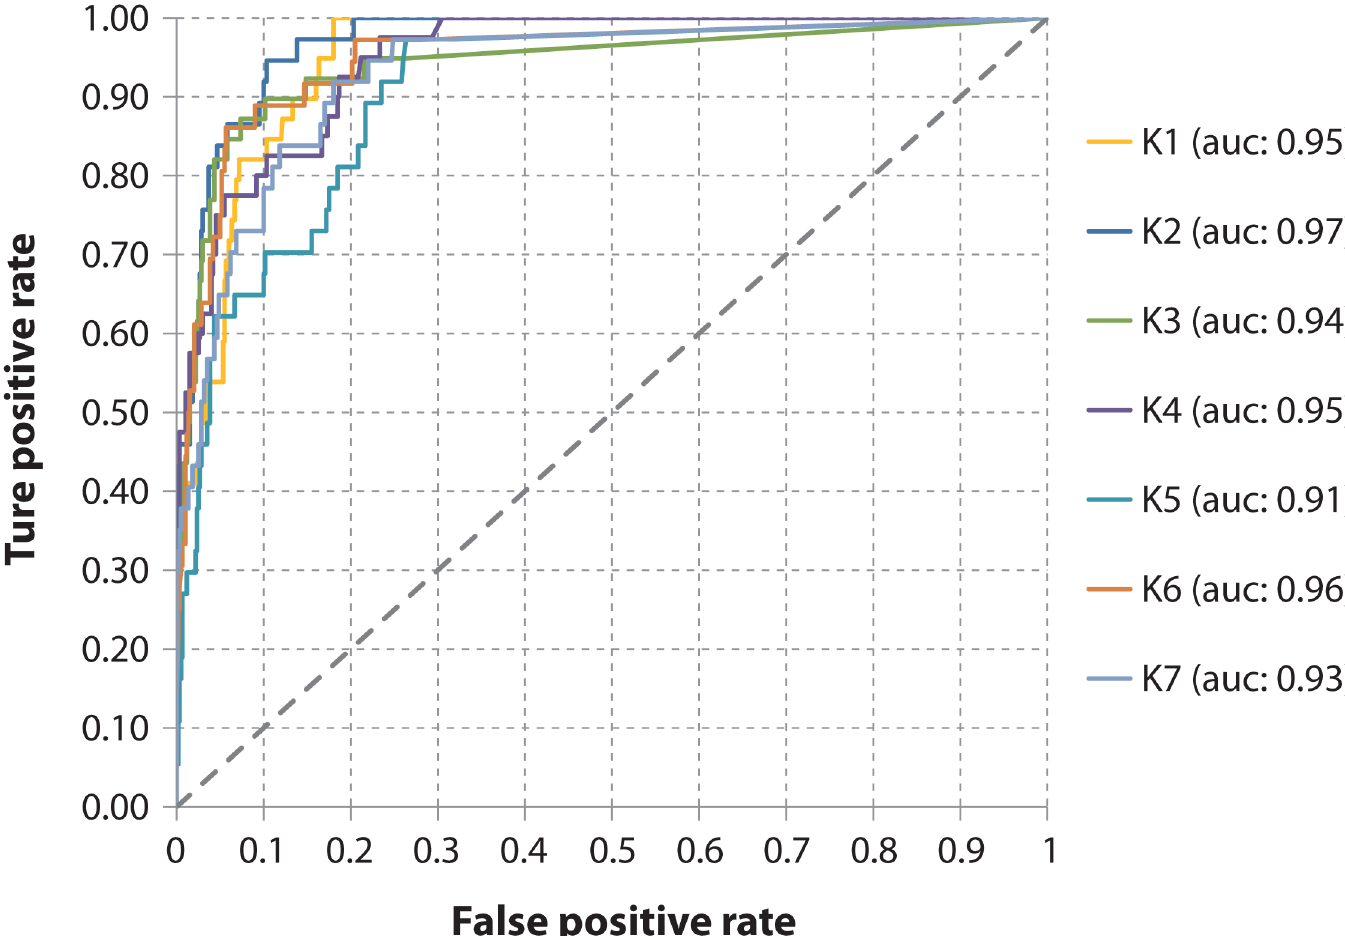
Fig 3. Validation of West Nile Disease presence prediction: receiver operating characteristic (ROC) curves in the k-fold (k = 7) iterations.